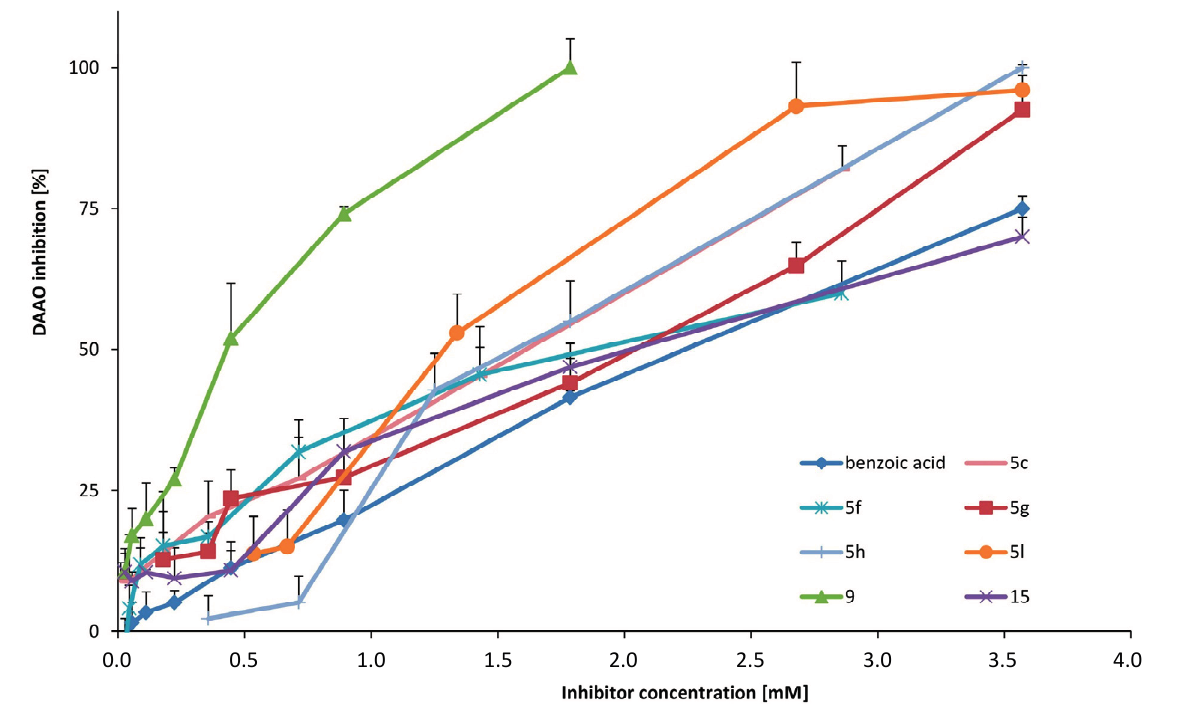
Figure 4. DAAO inhibition of the most active